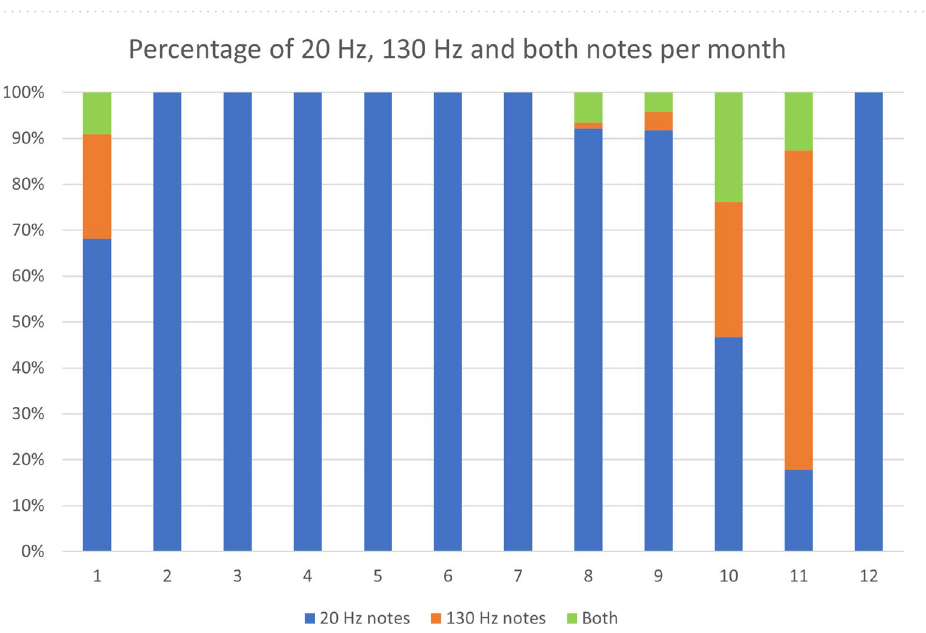
Figure 6. Histogram representing relative percentages of 20-Hz and 130 Hz per month (1–12) over the entire